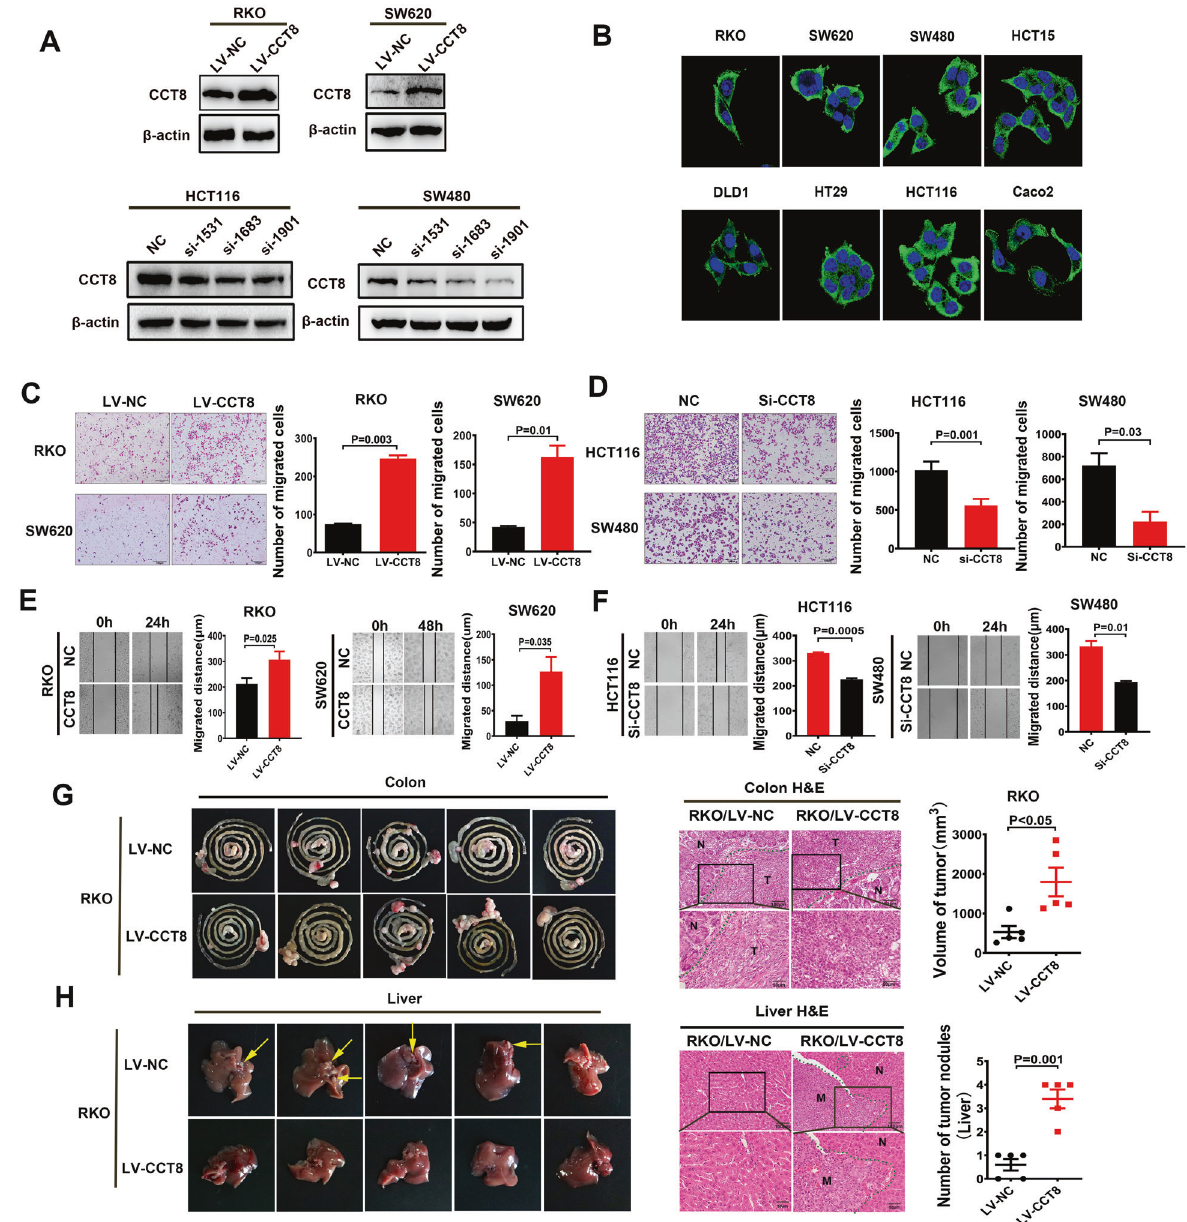
Fig. 2 CCT8 promotes CRC cell migration in vitro and metastasis in vivo. A CCT8 overexpressed lentivirus and three CCT8 siRNA were successfully constructed to study the effects of CCT8 in CRC cells. B The subcellular localization of CCT8 in CRC cells lines was assessed by immuno- fl uorescence. C , D Representative fi gures of Transwell assays indicate the stimulatory role of CCT8 on CRC migration. Bars on the right panel represent the number of invaded cells ( n = 3, P < 0.05). E , F Representative fi gures of the wound-sealing assays indicate that CCT8 could stimulate CRC cell migration. Bars on the right represent the migration distance of wound-healing assay ( n = 3, P < 0.05). G , H Caeca orthotopic transplantation assay indicates the stimulatory role of CCT8 on hepatic metastasis ( n = 5). The representative colon and liver samples are displayed and the HE staining of the representative tumors was placed on the middle panel, showing the boundaries between tumor and normal tissues. Bars of the right panel represented the volume of tumor in situ and number of metastatic nodules in liver